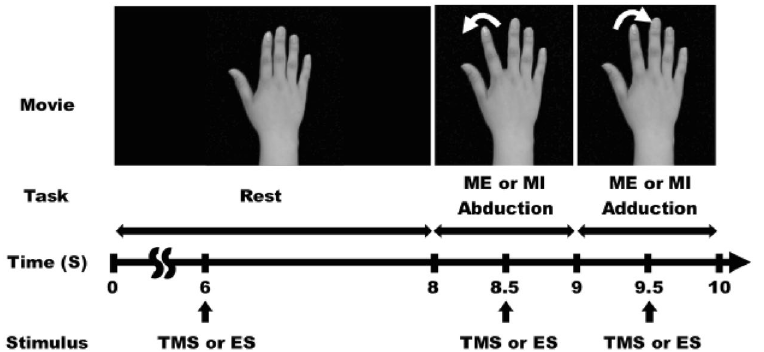
Figure 2. Schematic diagram of the time course of the task and stimulus. The movie showed the static hand image (8 s), right index finger abduction (1 s), and adduction (1 s). The subject performed motor imagery (MI) or motor execution (ME) task, concurrently with the index finger movement in the movie. TMS (Experiments 1, 3, 4, 5) or electrical stimulation (Experiment 2) was applied 6 s after the beginning of the rest phase or 0.5 s after the beginning of index finger abduction and